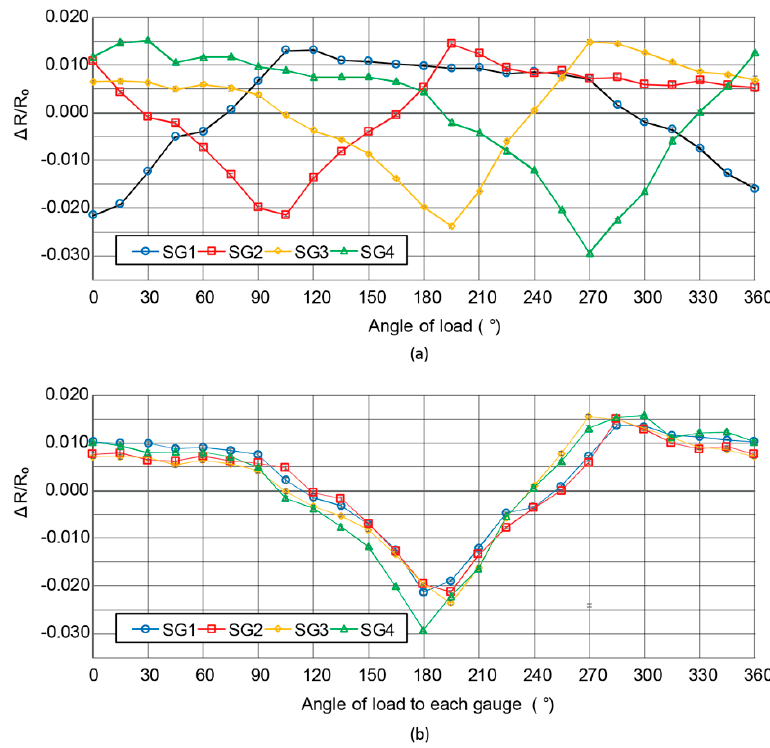
Figure 8. Results of the test for direction of load recognition. ( a ) The direction of rotation from 0 ◦ to 360 ◦ and the ratio of resistance change for each degrees of the same load applied. The results were replotted for 0 ◦ defined as the opposite of each strain gauge as shown in ( b ) the replotted graph.